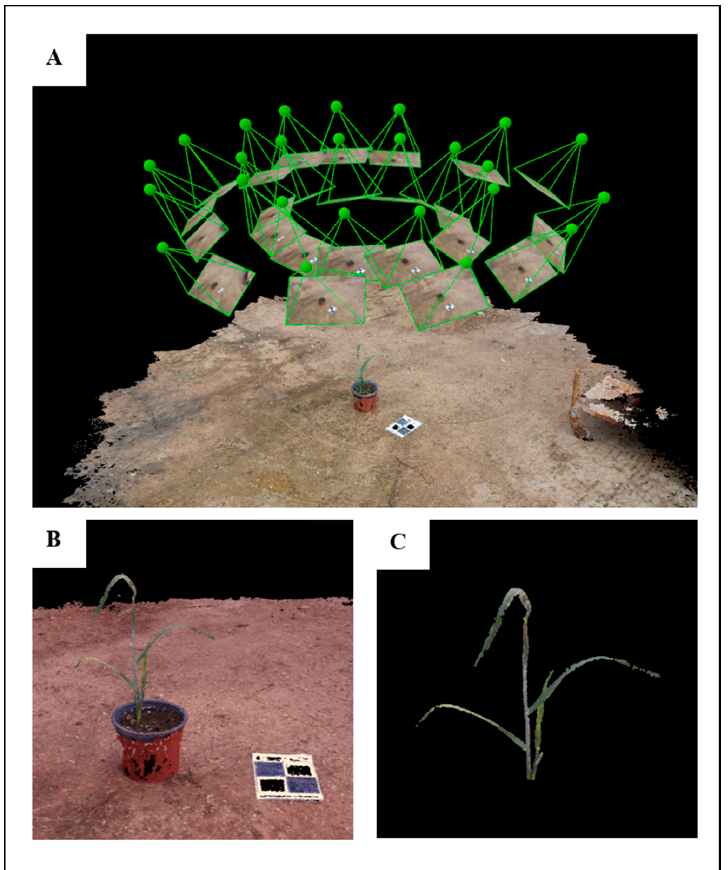
Figure 2. Main stages of the 3-D model reconstruction. ( A ) 3-D model of the entire net-house scene where the triticale plants were imaged, and the camera positions (green dots) orientations and imaged areas. ( B ) Blowup image of the 3-D model of a single triticale plant before and ( C ) after the pre-processing stage.